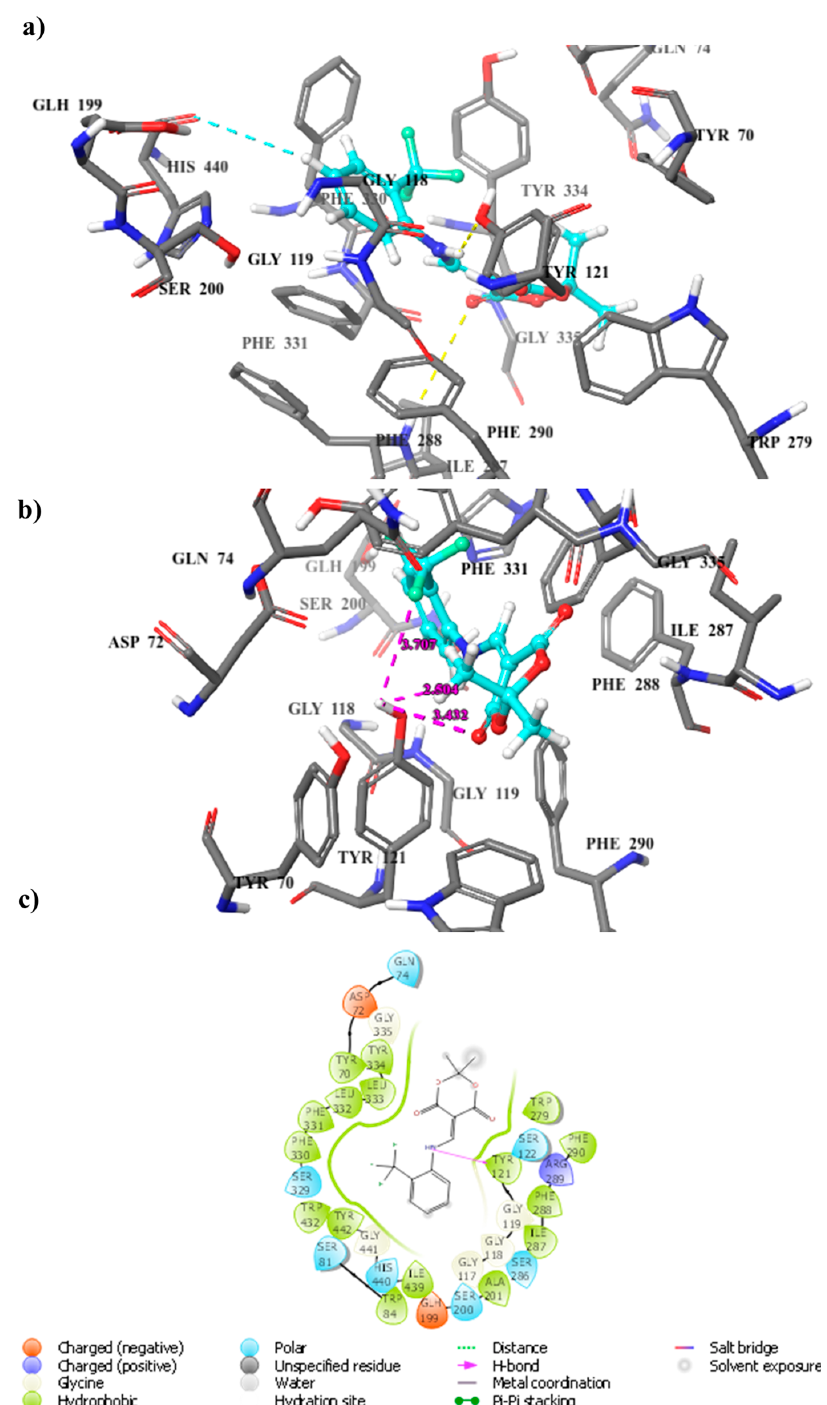
Figure 4. Binding mode of compound 3 inside the active site of AChE. ( a,b ) Docking poses of compound 3 in tri ‐ dimensional space. Ligands are shown in ball and stick mode in elemental and cyan color, and the key residues are shown by stick mode, elemental color, and green color respectively. ( a ) Aromatic hydrogen bonding and hydrogen and halogen bonding of ligand atoms with residue atoms is shown in pink colored dashed lines. ( b ) Hydrogen and halogen bonding of ligand atoms with residue atoms is shown in pink colored dashed line ( c ) Docking pose of compound 3 inside the active site in two dimensional space.